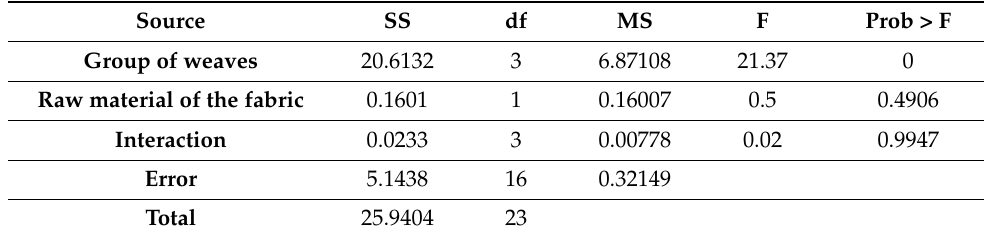
Figure 9. Confidence intervals of the shrinkage in the weft direction of different raw materials. The same hypotheses were proposed during the analysis of the shrinkage in the direction of the warp. The results of the ANOVA can be seen in Table 4. Table 4. ANOVA results for shrinkage in the warp